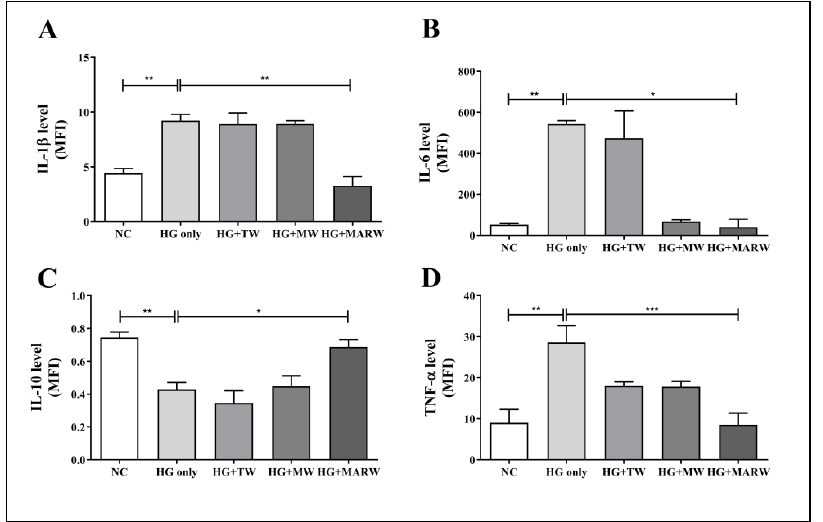
Figure 4. Effects of MARW on MAPK and the pathway that leads to fibrosis in HG-induced HK-2 cells. HK-2 cells were induced with glucose (71.68 mM) for 24 h and were treated with 10% TW, MW and MARW. ( A ) MAPK (p-JNK and p-p38) pathway along with ( B ) fibrosis-linked ( α -SMA and MMP3) proteins were analyzed. * p < 0.05, and ** p < 0.01 represent significant differences based on Tukey’s ANOVA test. Values represent the mean ± SEM. Abbreviations: NC, normal control; TW, tap water; MW, mineral water; HG, high glucose; MARW, magnesium-enhanced alkaline-reduced water; MAPK, mitogen-activated protein kinase; α -SMA, alpha-smooth muscle actin; MMP3, matrix metalloproteinase 3; p-JNK, p-jun N-terminal kinase.